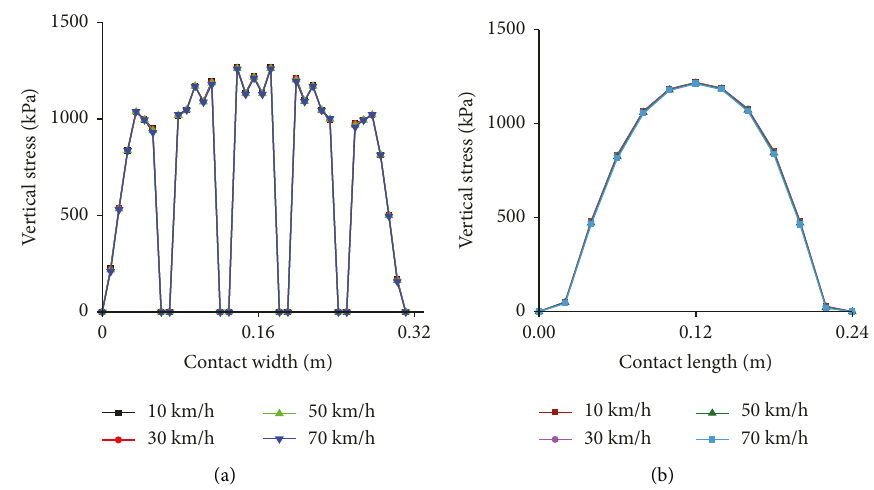
Figure 12: Vertical stress under different velocities: (a) width and (b)